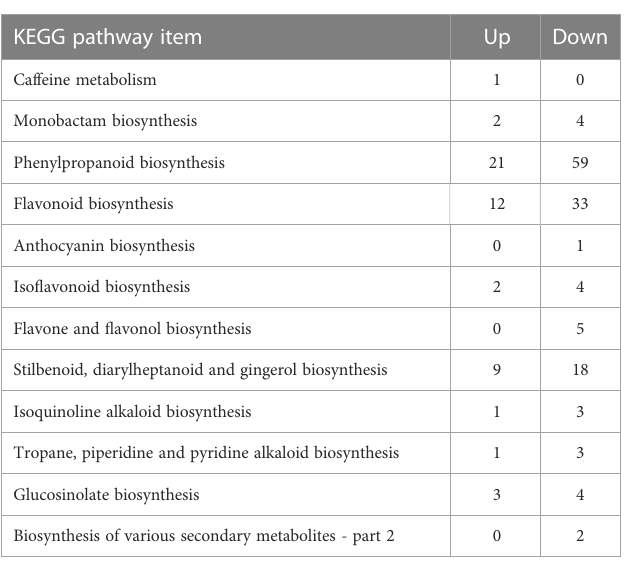
TABLE 3 KEGG pathway annotation and number of DEGs in biosynthesis of other secondary